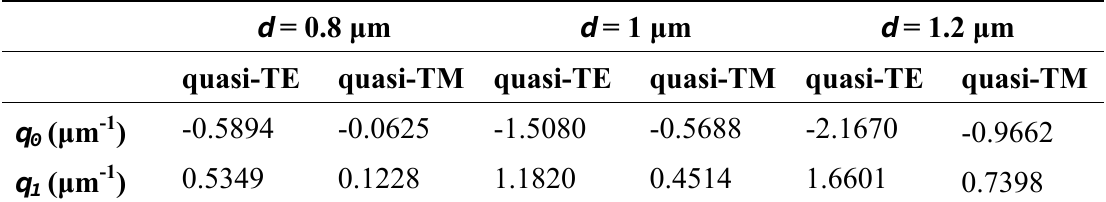
and q for d = 0.8 μ m, 1 μ m, 1.2 μ m. 0 1